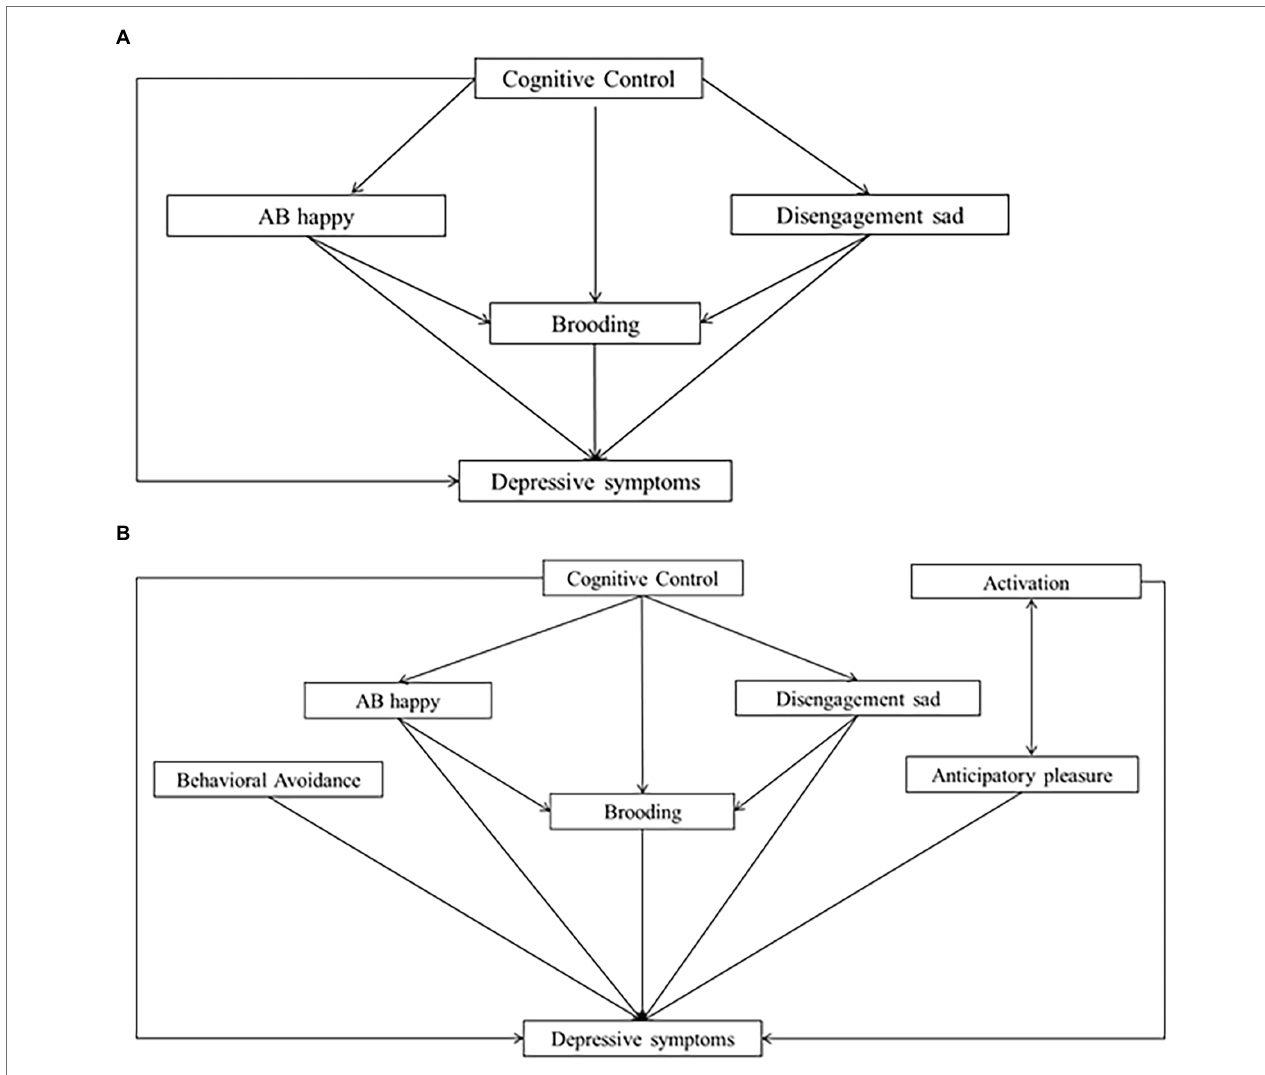
presented until a response was made. A black background intertrial was then presented for 300 ms before the next trial started. The sequence of events in a test trial is depicted in Figure 3 . In the test trials, half of positive faces were valid (28 trials; left cue–left target and right cue–right target) and half were invalid (28 trials). The same proportions were used for sad and neutral faces, with half valid (28 trials) and half invalid (28 trials; left cue–right target and right cue–left target). Fifty-six of the remaining stimuli were no-cue and 10 were digital trials to enhance the probability that participants would maintain their gaze in the middle of the screen. The fixation cross was replaced by a digit for 450 ms, after which no cue or target followed and participants were instructed to report the digit aloud as quickly as possible. The stimuli were presented at random in the left or right hemifield